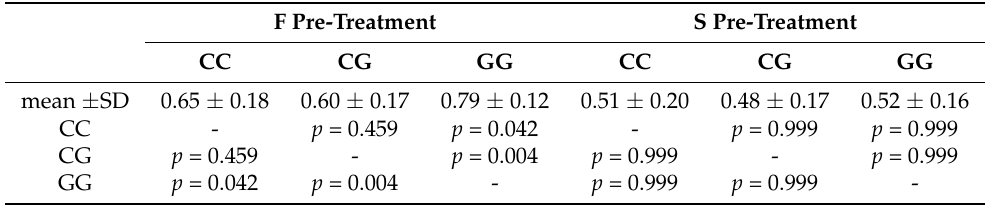
Table 4. Mean±SD values of steatosis and fibrosis before treatment according to PNPLA3 genotype (Bonferroni post hoc test pre-treatment).